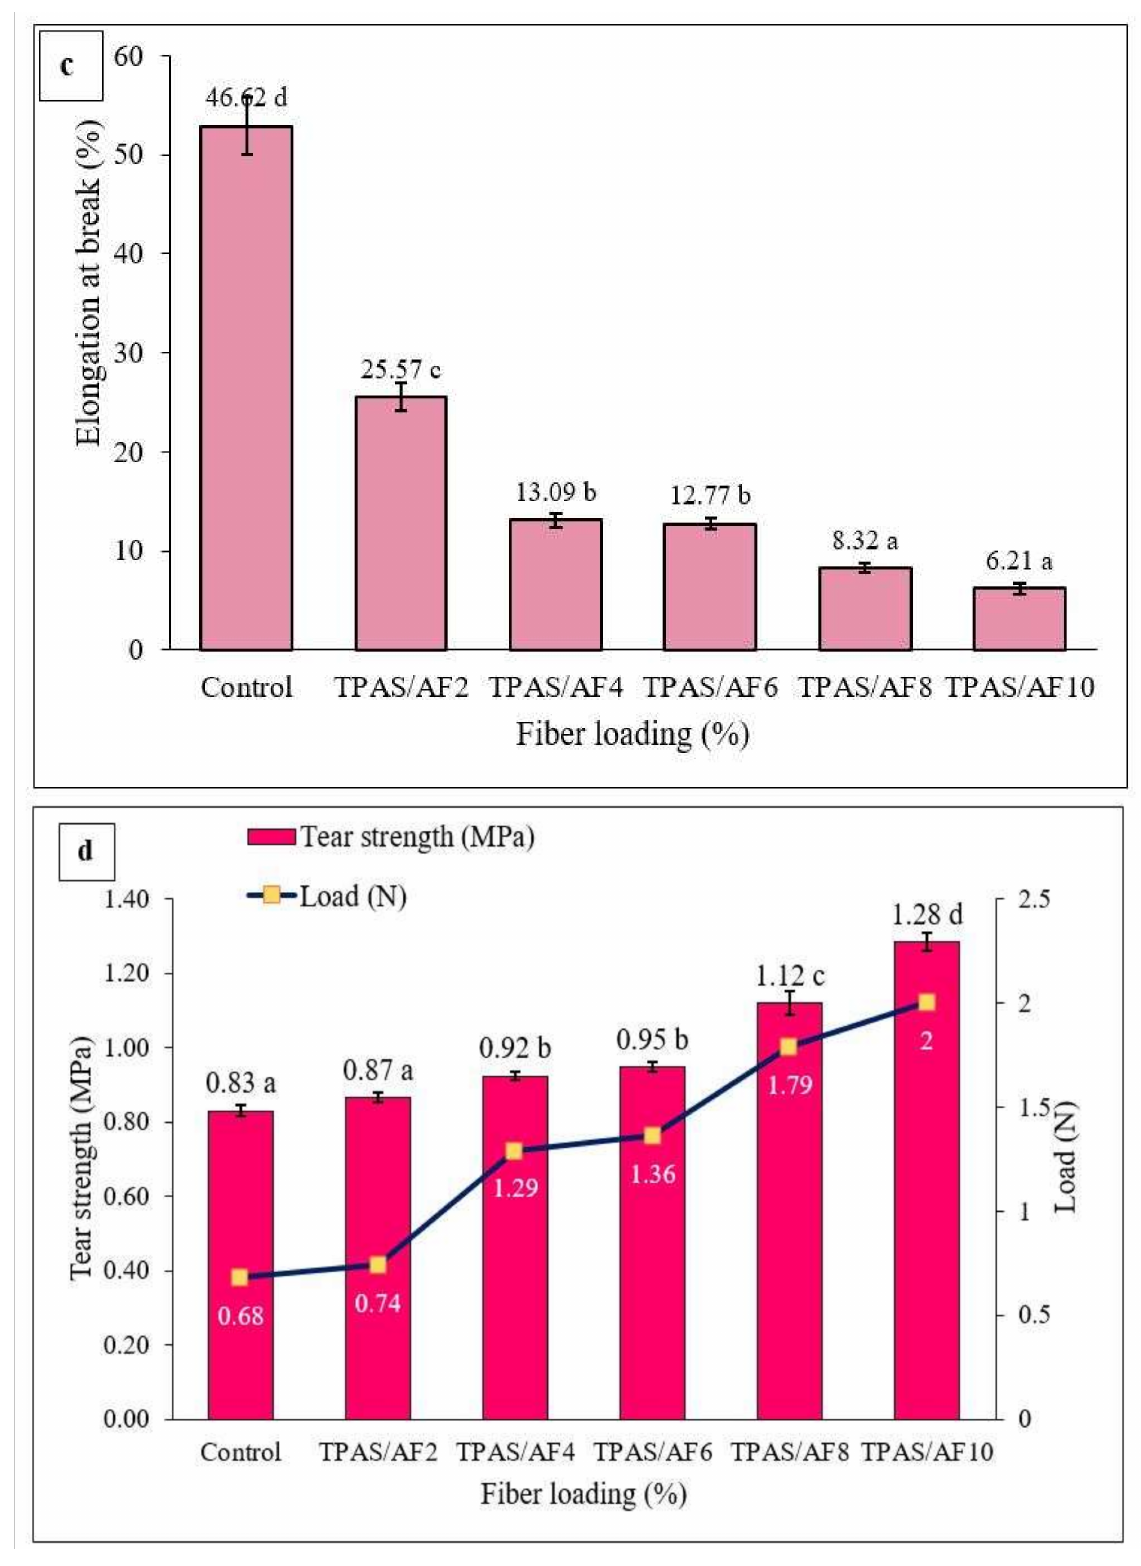
Figure 5. Mechanical performances of the thermoplastic composite film. ( a ) TS; ( b ) YM; ( c ) EAB; and ( d ) tear strength and load curve. Values with different letters in the figures are significantly different ( p <